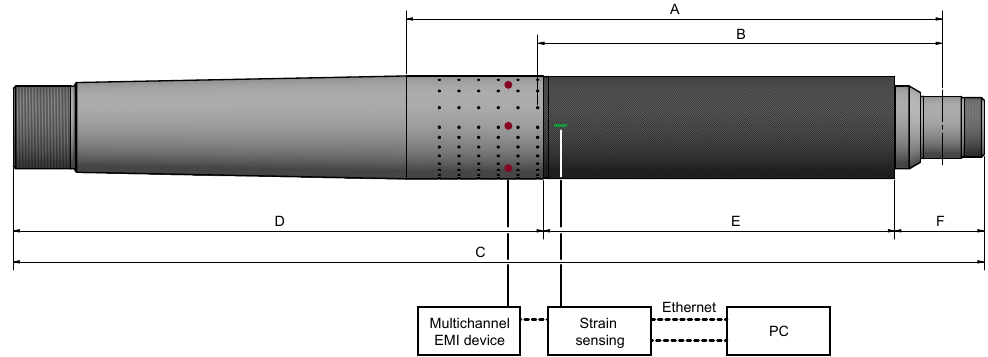
Figure 2. Geometry of the rudder stock, the sensor locations and an illustration of the data acquisition procedure.